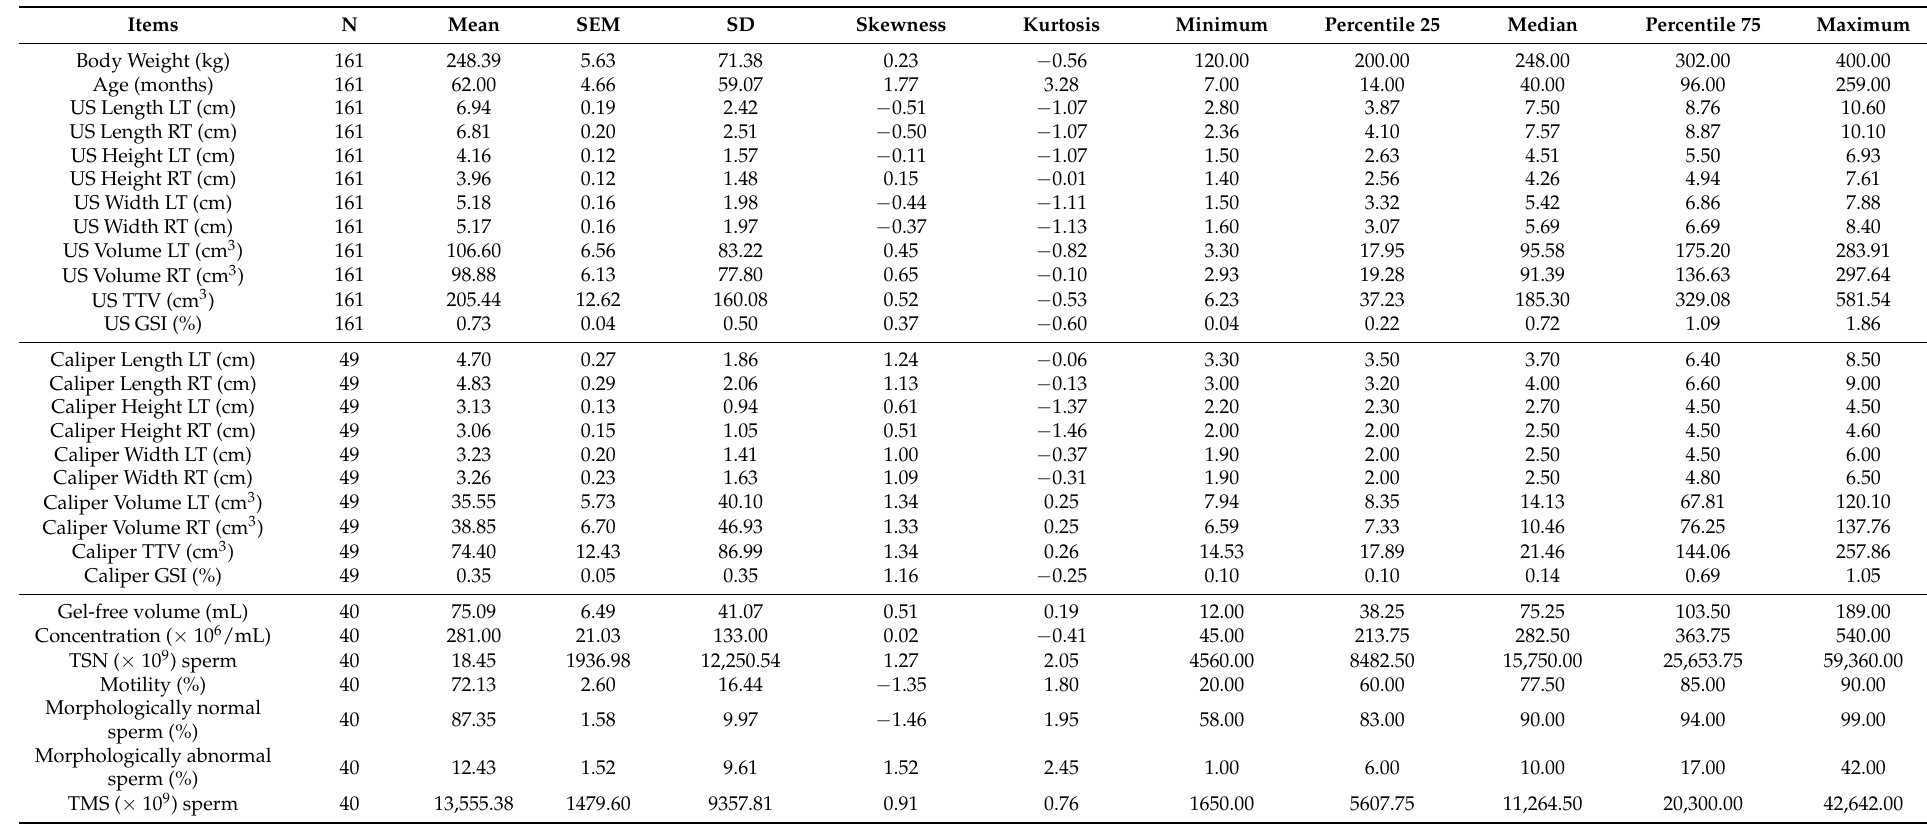
Table 2. Descriptive statistics for testicular US measurements in 23 donkeys ( n = 46 testis, observational sample) and precision caliper after orchiectomy in seven of these donkeys ( n =